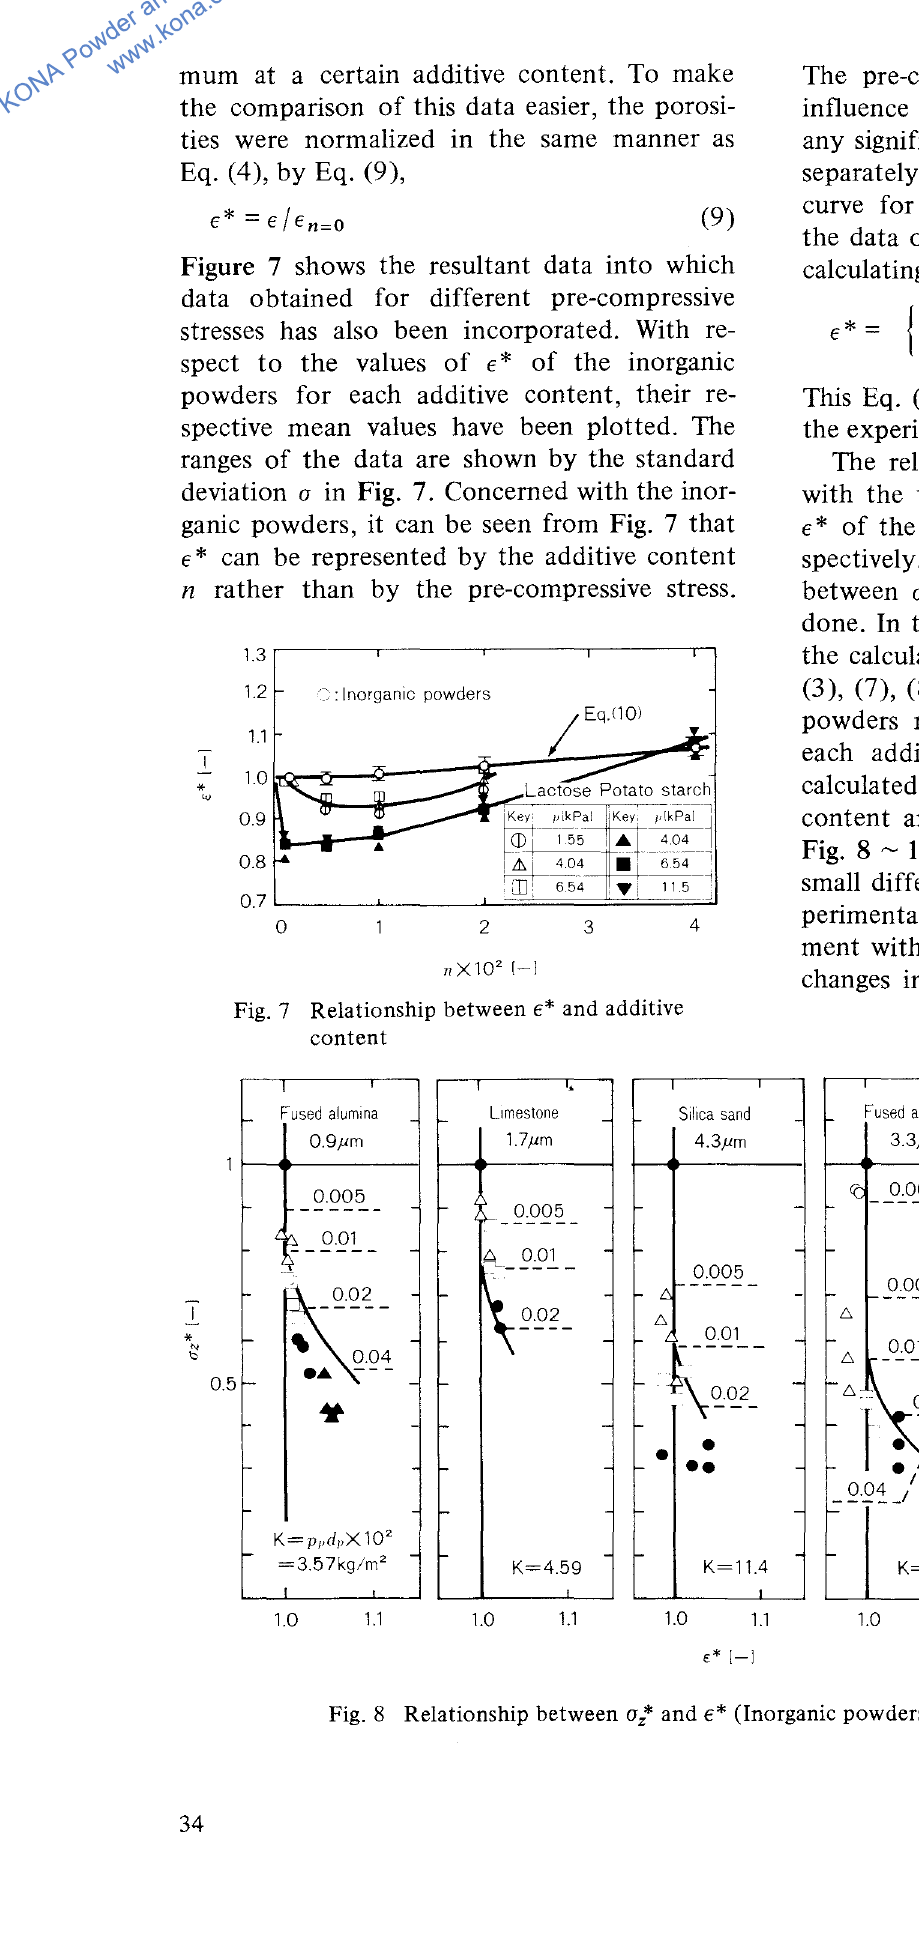
Fig. 8 Relationship between az* and €* (Inorganic powders) (1: n ~0.0 1, II: 0.01